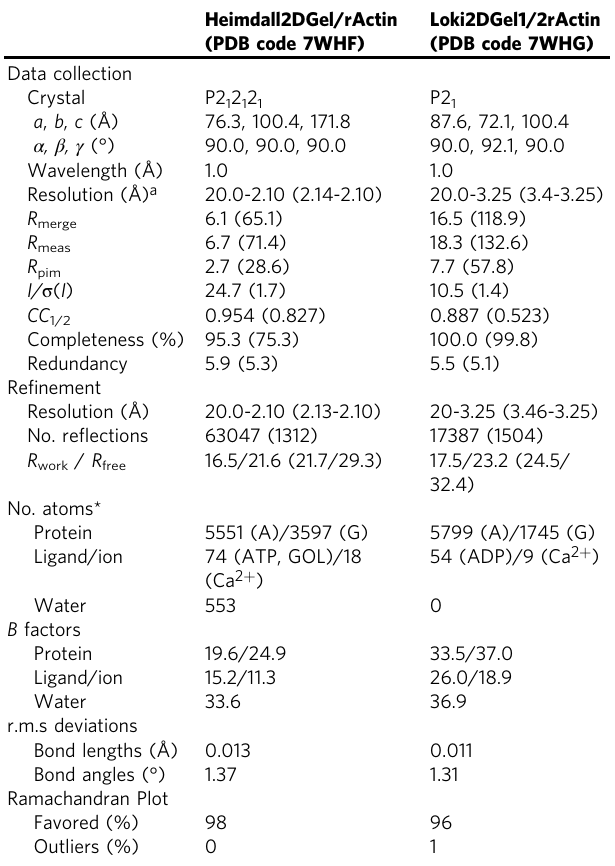
Table 1 X-ray diffraction data collection and re fi nement statistics. Heimdall2DGel/rActin (PDB code